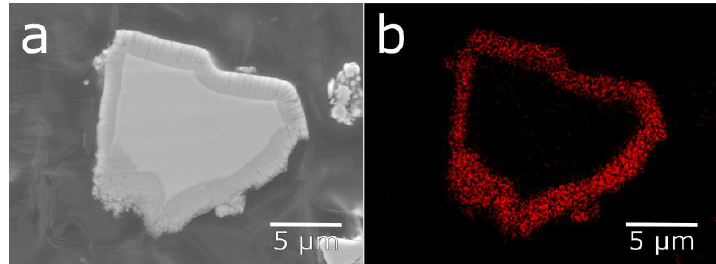
Figure 6. Cross-sectional micrographs of ( a ) cycled material and ( b ) ball-milled material. Figure 7. SEM image ( a ) and EDS map with oxygen Kα counts ( b ) of a corroded alloy particle, showing a surface layer with elevated oxygen content.